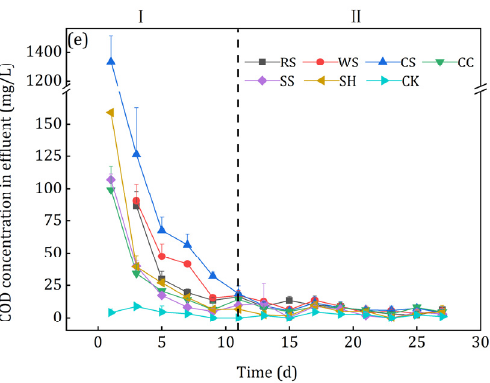
Figure 7. Nitrate removal performance of the investigated agricultural wastes: (a) Nitrate removal; (b) TN removal; (c) Nitrite accumulation; (d) NH4+-N accumulation; (e) COD accumulation.